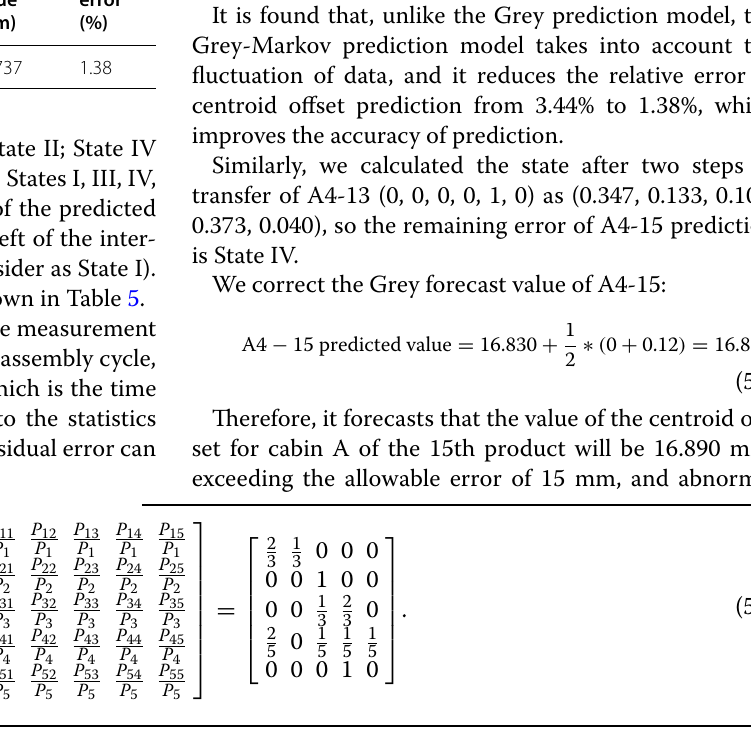
Table 6 Comparison between Grey model and Grey-Markov model Product